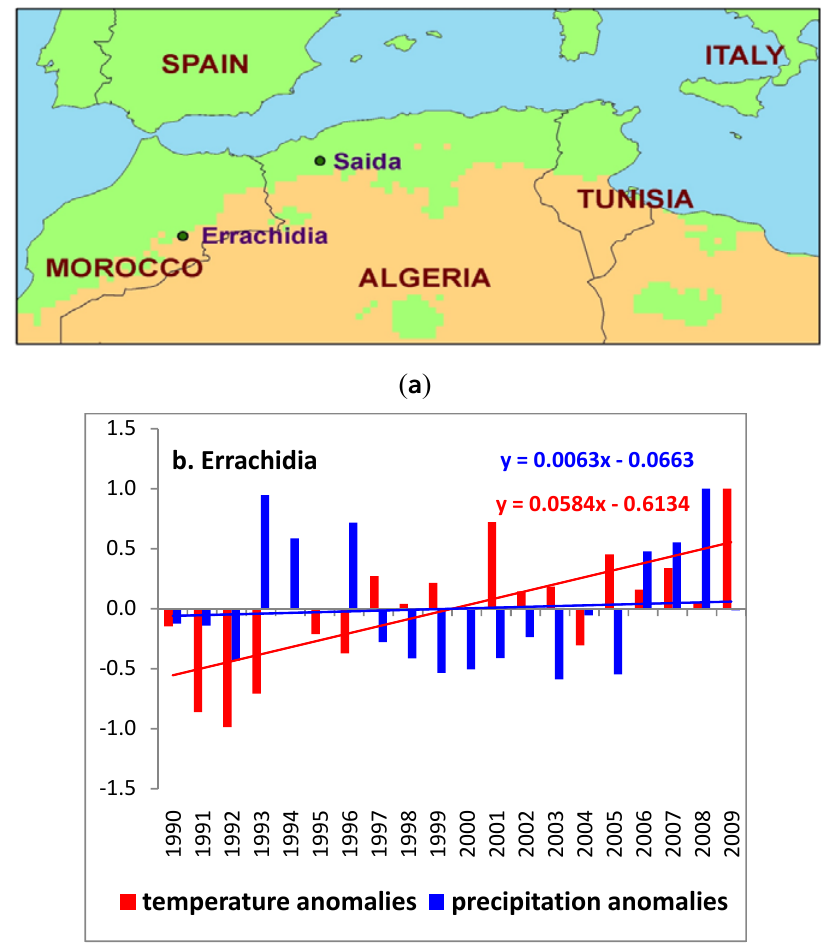
Figure 1. ( a ) Study area, showing the two provinces of Saida and Errachidia; ( b ) Annual mean temperature and precipitation anomalies for Errachidia; ( c ) Annual mean temperature and precipitation anomalies for